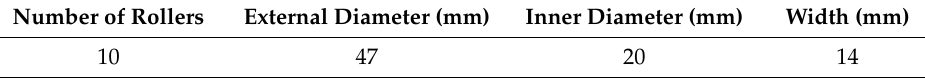
Table 1. Structure parameters of NTN N204 bearing .